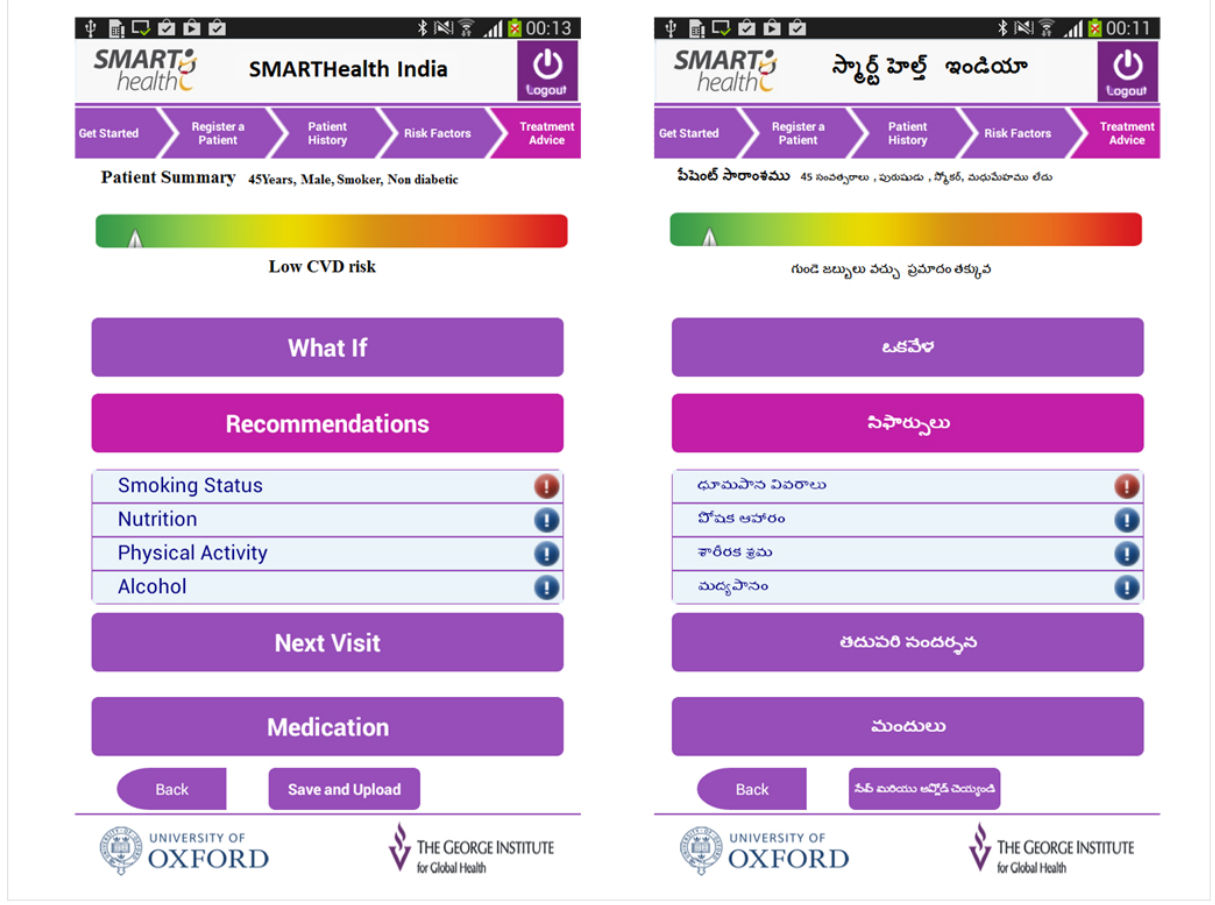
Figure 1. Treatment advice screen of the app in English and Telugu (local